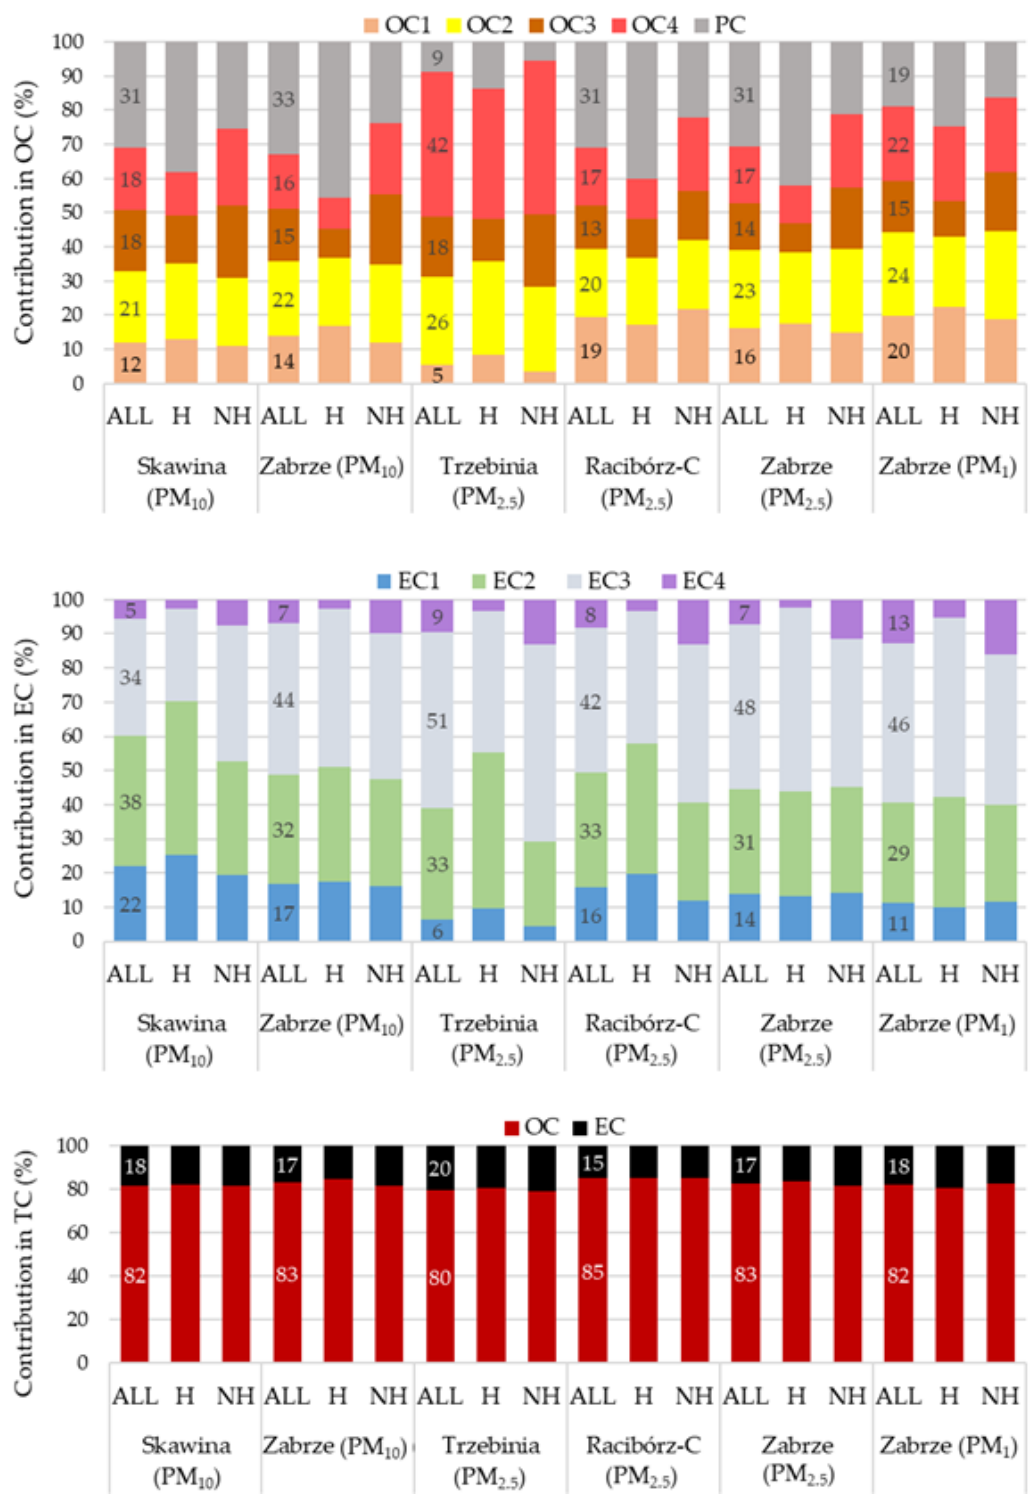
Figure 9. Profiles of nine temperature fractions against the share of OC and EC in total TC at the considered urban background sites.